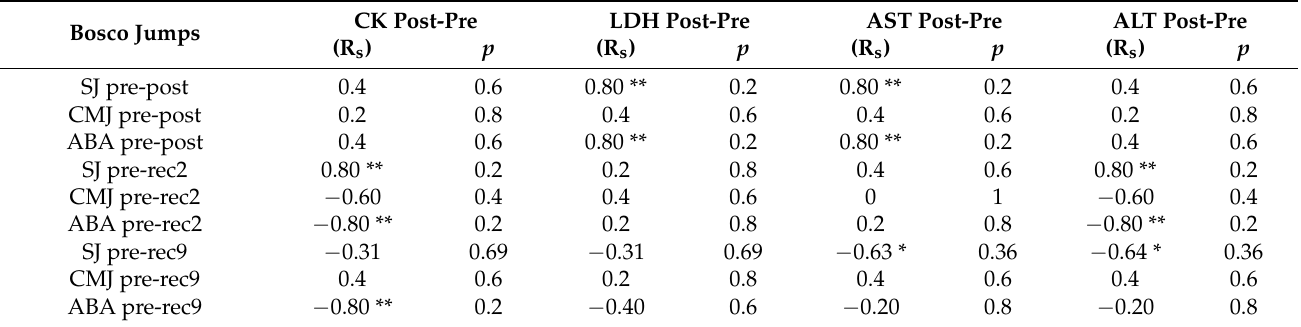
Table 5. Spearman’s rank correlation coefficient (R s ) and probability ( p ) pre and